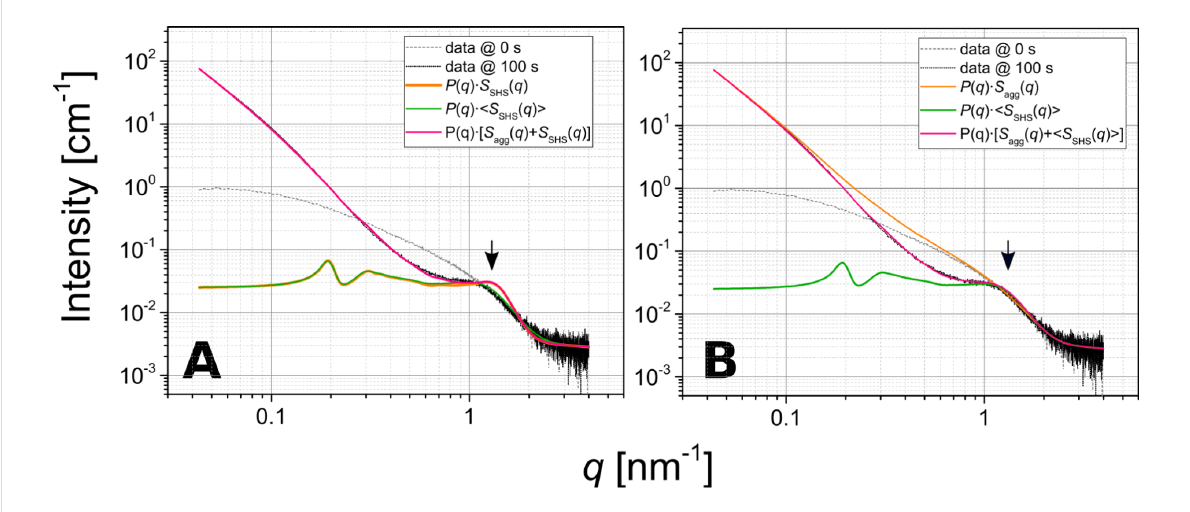
Figure 3: Fitting of the structure-factor contributions to a scattering curve measured at 100 s during the composite-formation processes. A) Compari- son between the effect of the unsmeared (monodisperse aR eHS , red line) S SHS ( q ) from Equations 5–14 and the smeared (polydisperse, green line) < S SHS ( q )> from Equation 18. Fits yielded ν = 0.454 ± 0.008, aR eHS = 0.979 ± 0.036 nm, < aR eHS > = 0.930 ± 0.000 nm, and σ = 0.533 ± 0.050 nm; the complete structure factor fit (pink line), which includes the unsmeared S SHS ( q ), illustrates that the form of the function affects only the correlation peak at q ≈ 1 nm − 1 (arrow), and not the low- q scattering intensity of the aggregates; B) the final fit to the data (pink line) with each structure-factor contribu- tion plotted separately (green and orange lines). Parameters for < S SHS ( q )> are the same as in panel A, whereas for the S agg ( q ) from Equation 17, we obtained A = 0.0437 ± 0.0001 and D = 2.37 ± 0.00. The data uncertainties are not shown for